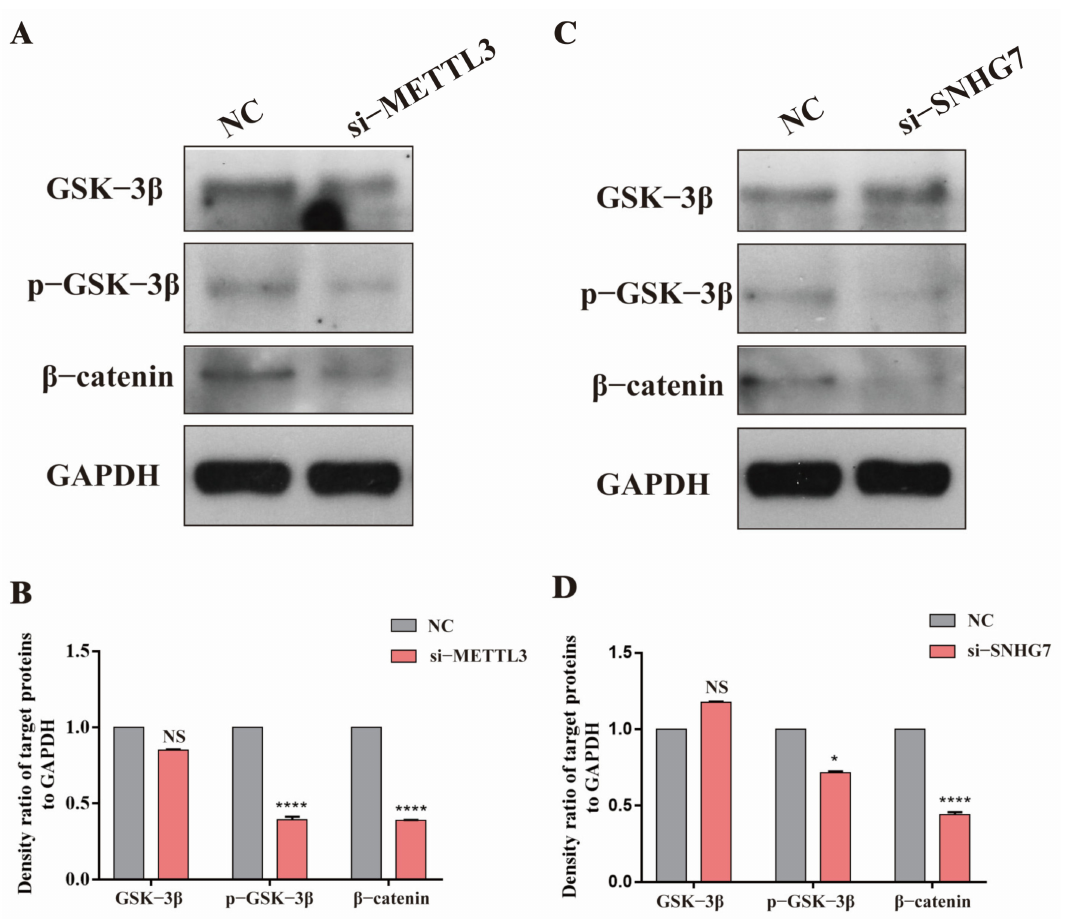
Figure 7. Demonstration of the METTL3/lncSNHG7axis and its regulatory analysis of Wnt/ β -catenin signaling pathway. ( A , C ) The protein expression levels of β -catenin and GSK-3 β phosphorylation under lncSNHG7 and METTL3 knockdown. ( B , D ) The density ratio of target proteins to GAPDH. The data were represented as means ± SD for each group: * p < 0.05, **** p < 0.0001, NS: Not Statistically